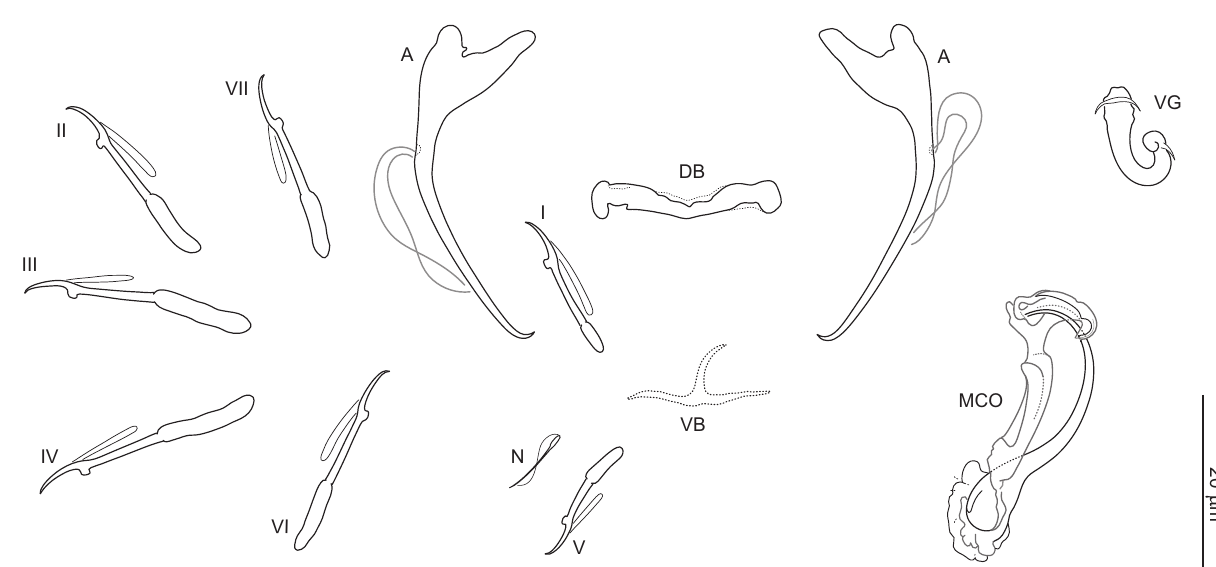
Figure 12. Sclerotized structures of Dactylogyrus leptus n. sp. ex Chondrostoma knerii . A, anchor; DB, dorsal bar; VB, ventral bar; N,